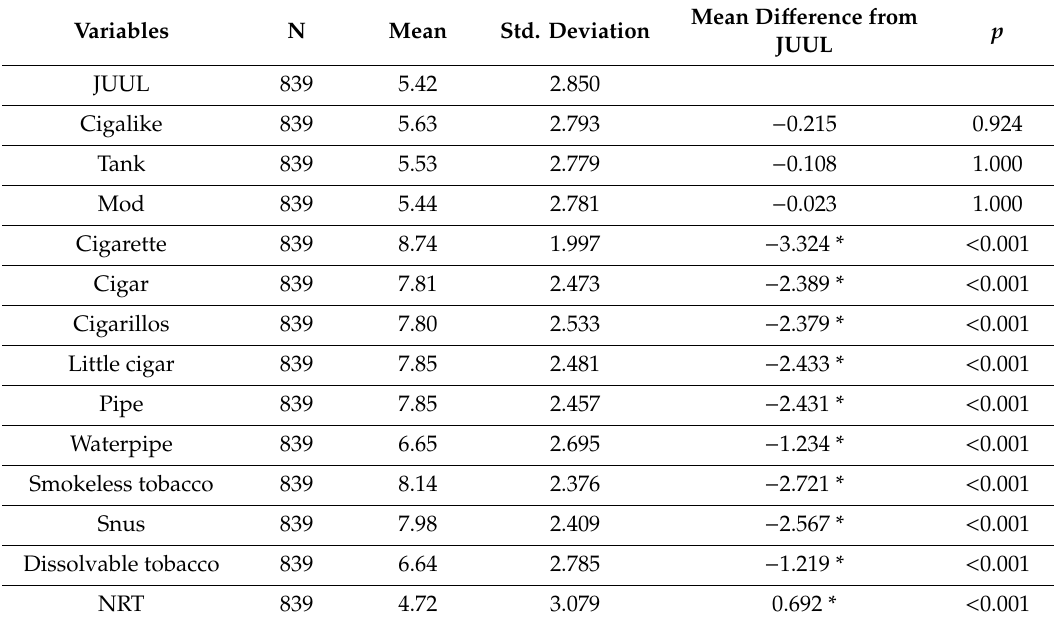
Table 2. Di ff erences in absolute harm perceptions of JUUL vs. all other tobacco products.